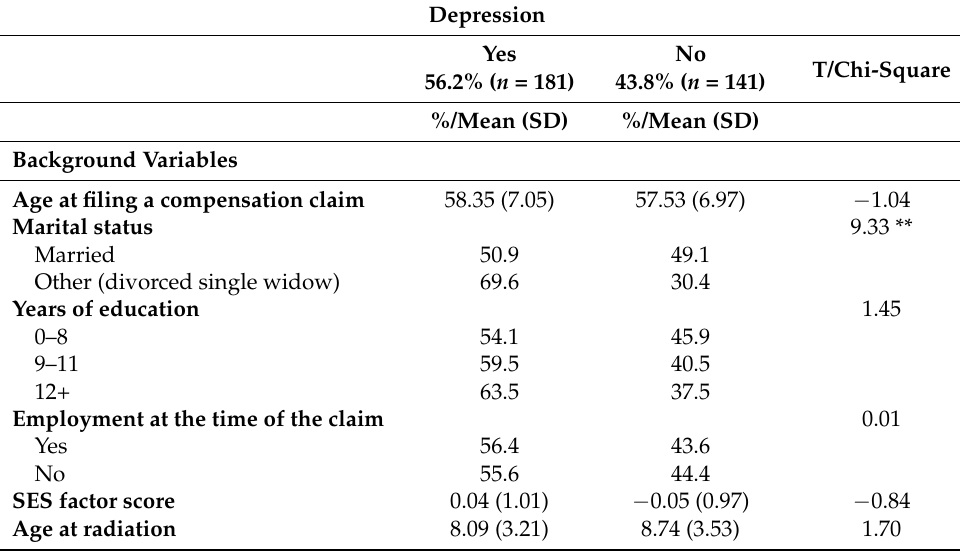
Table 2. Bivariate analyses of the study variable by depression (N =